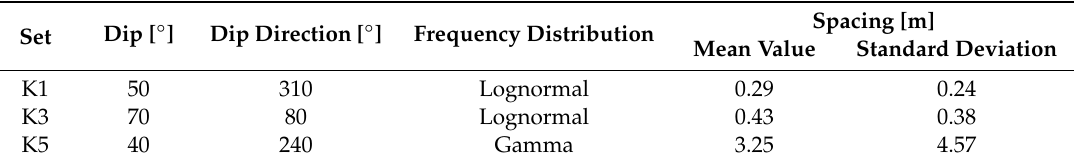
Table 2. Orientation and spacing values of the discontinuity sets mostly predisposed to generate a rockfall event and their corresponding frequency distributions.